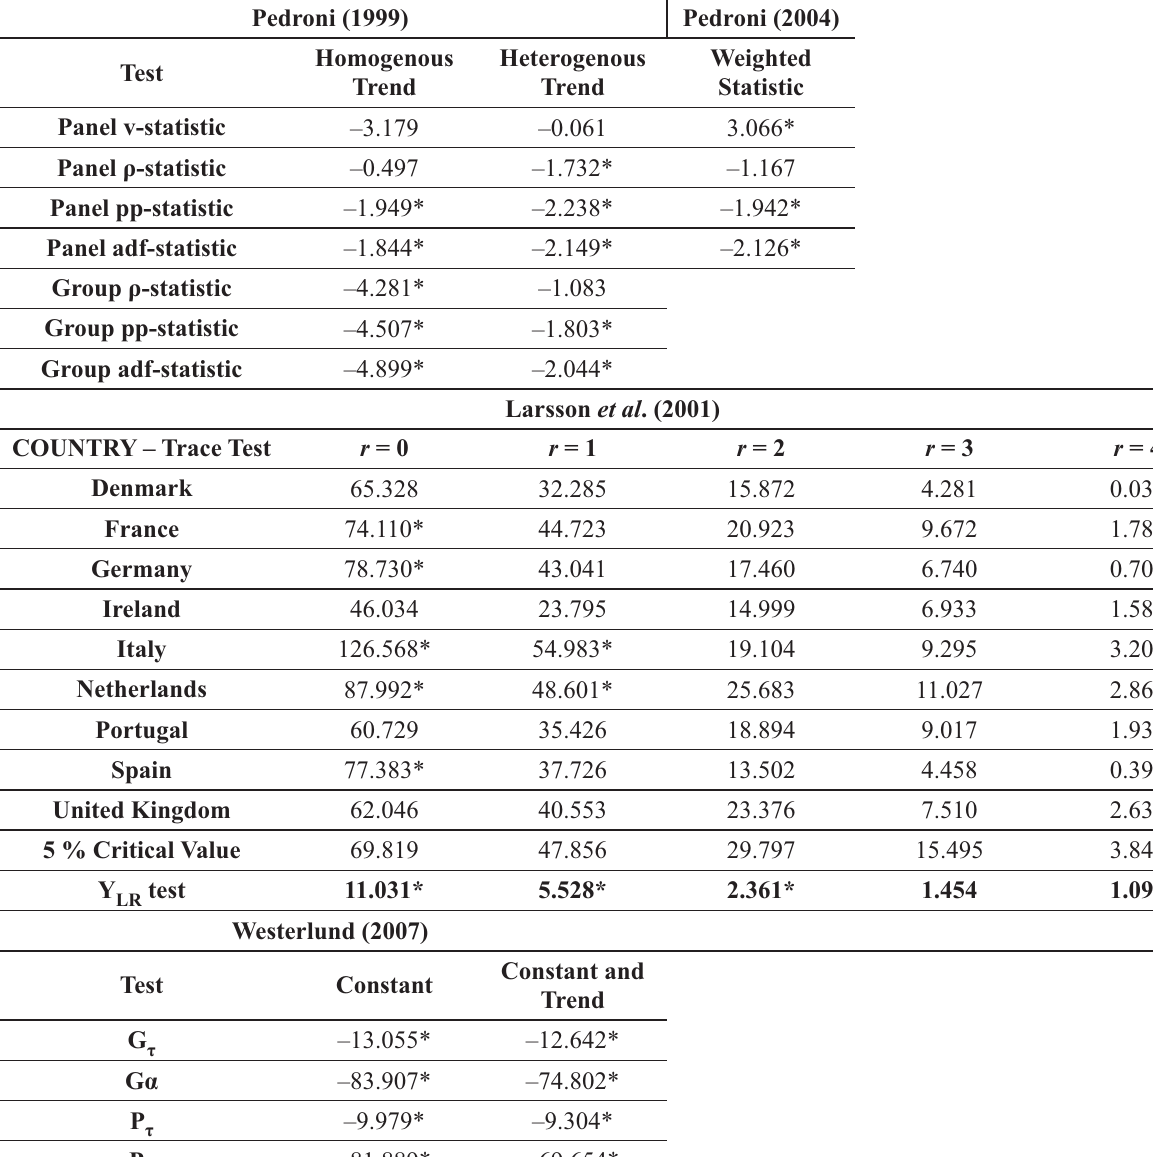
Table 2. Panel Cointegration